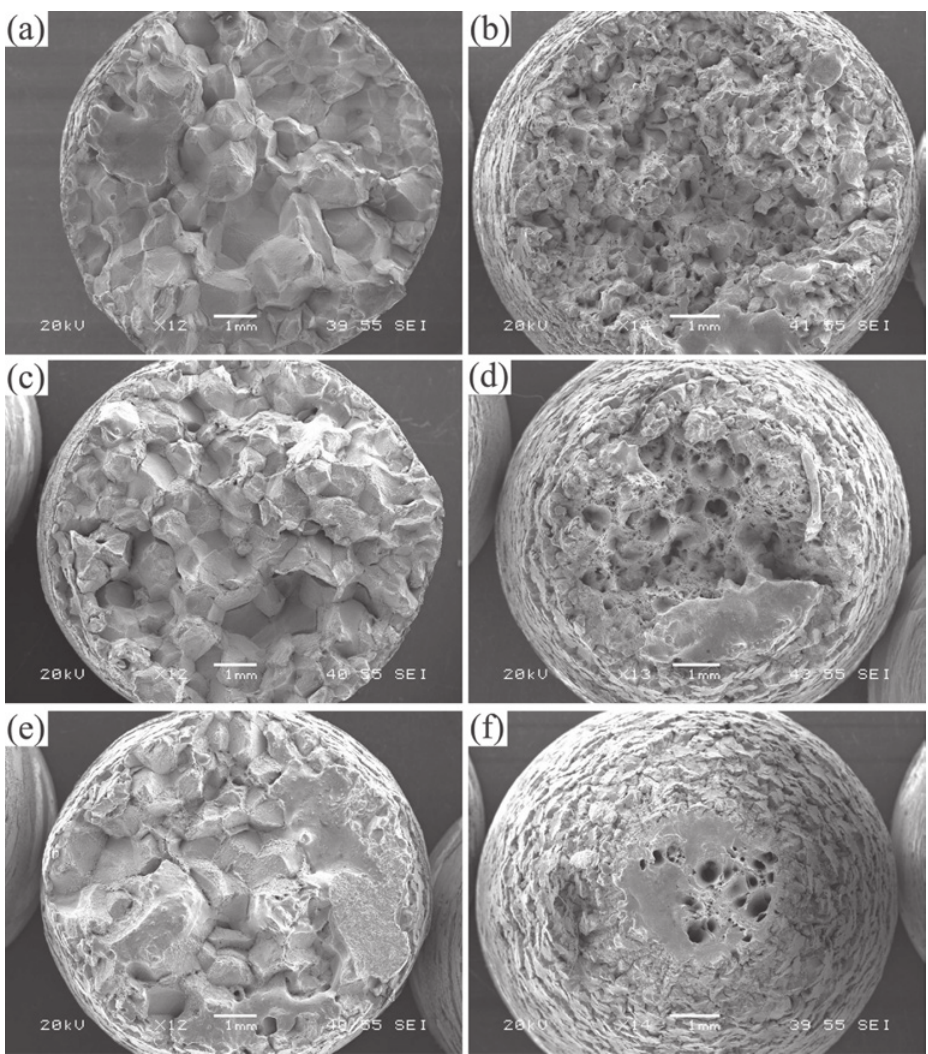
Fig. 2: Fracture morphology of tensile-tested samples: (a) alloy 1 at 900 °C, (b) alloy 2 at 900 °C, (c) alloy 1 at 950 °C, (d) alloy 2 at 950 °C,